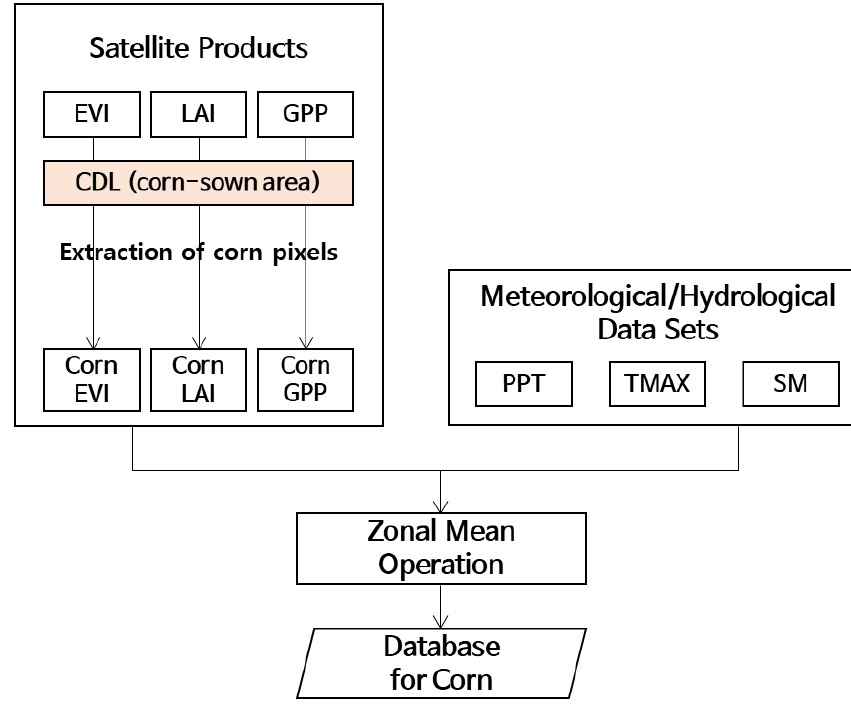
Figure 2. Process for constructing the match-up database for corn yield for the counties of the study area.